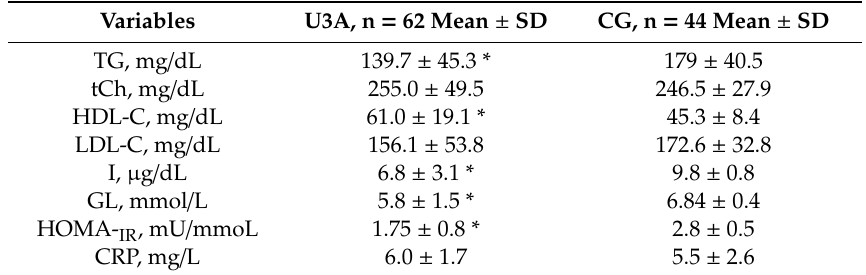
Table 3. The blood levels of lipid profiles and insulin resistance biomarkers of